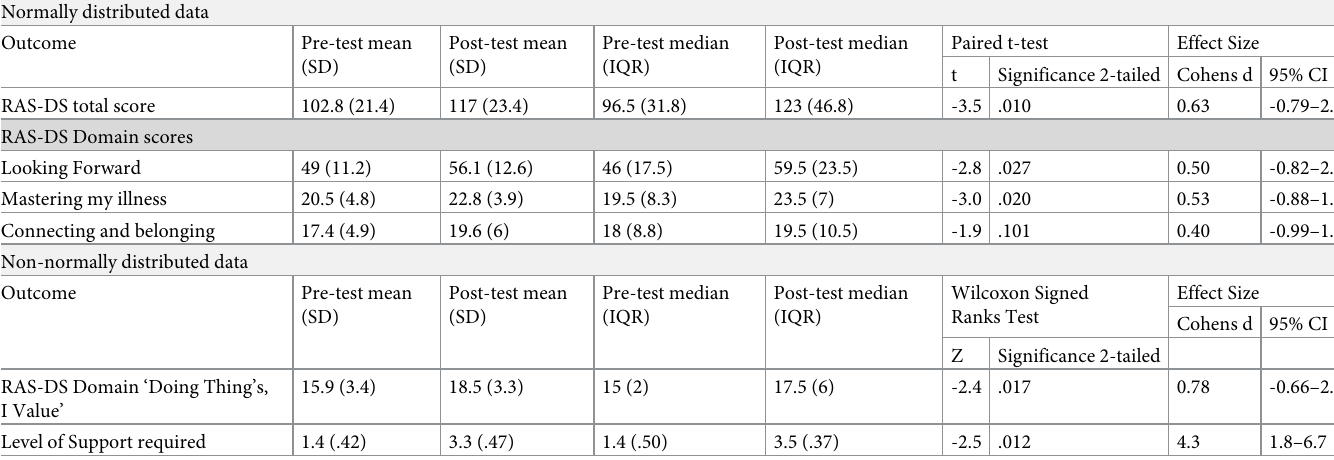
Table 3. Pre-post statistical analysis of RAS-DS & level of